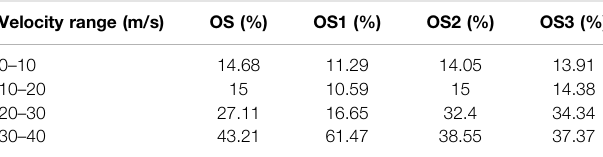
TABLE 3 | Statistical results of proportion of velocity ranges of different structures at outlet section.